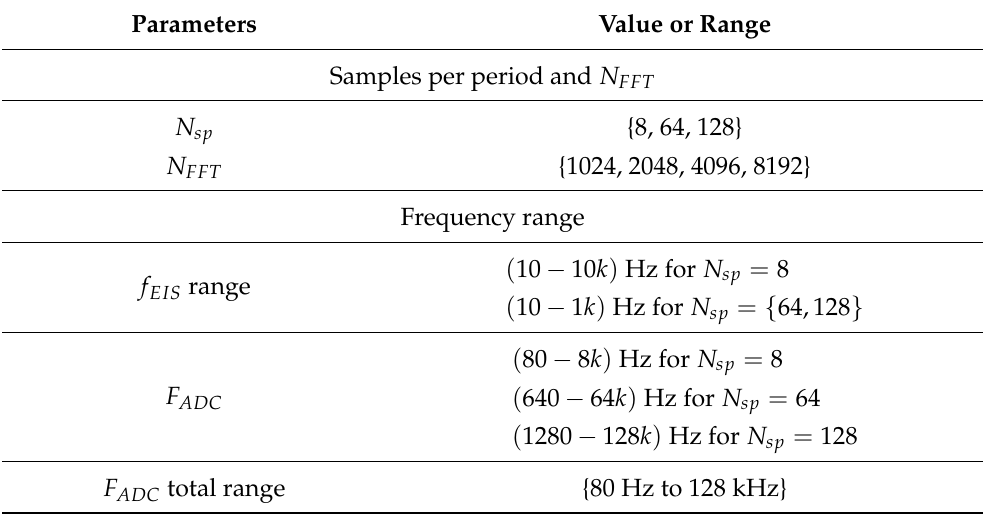
Table 7. Parameters and ranges of EIS experiments.